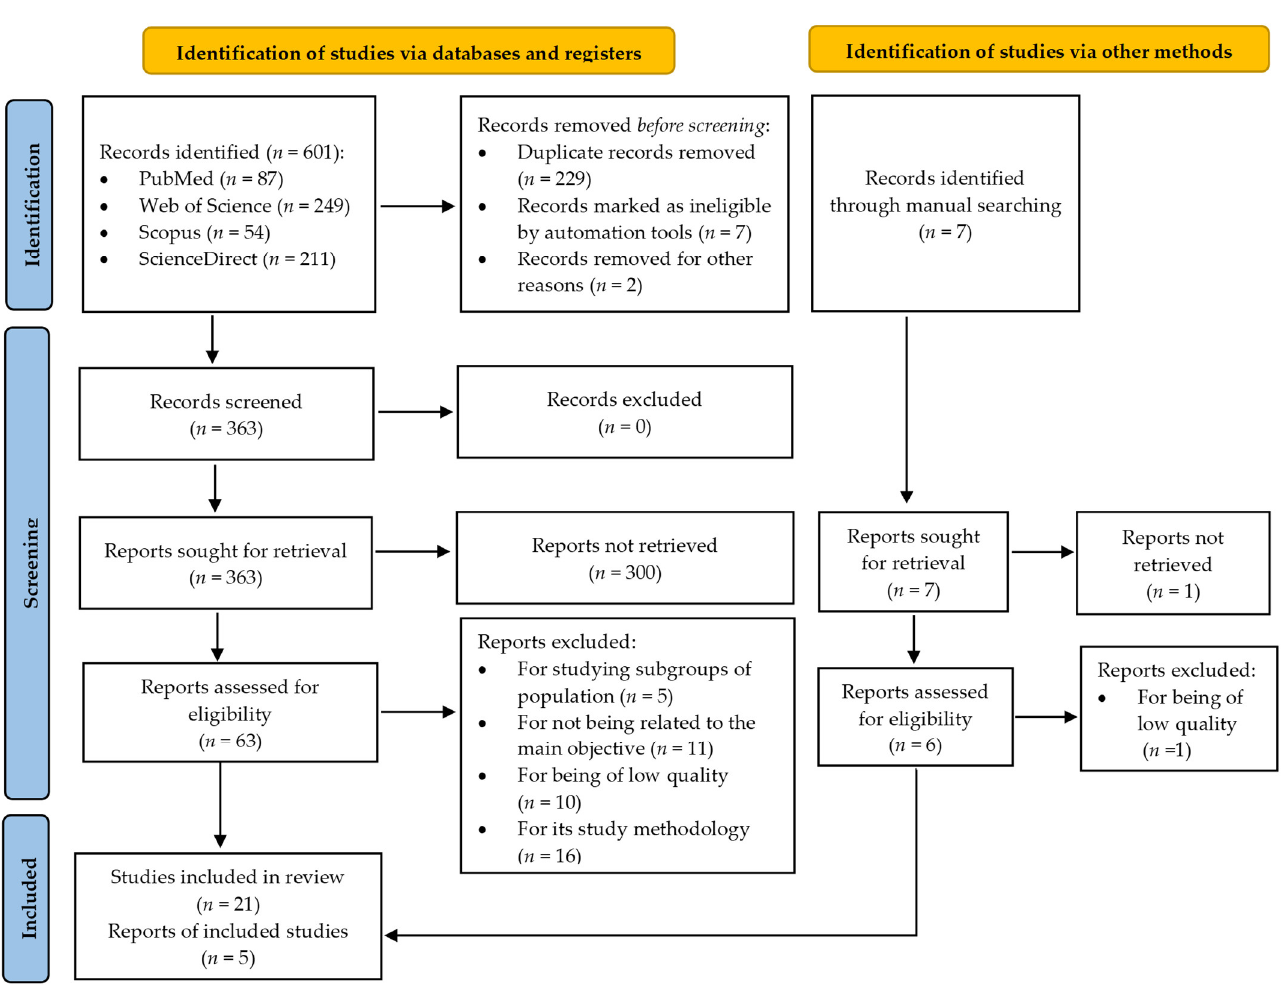
Figure 1. Study selection flowchart.